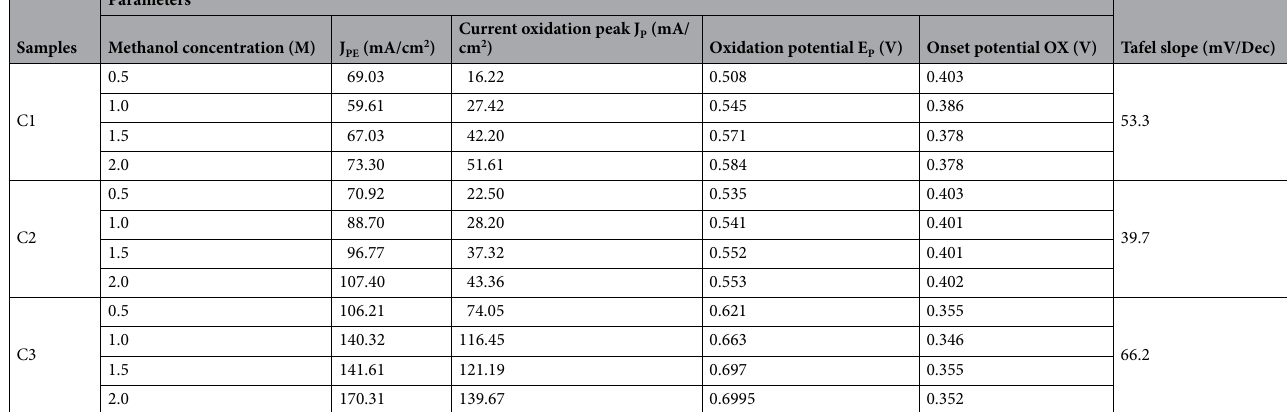
Onset potential. Onset potential is a meaningful metric used to assess EC activity. This represents the possibil- ity of the existence of reaction pathways in which all reaction steps have negative free energies. In other words, the electrode overpotential is indicated by the onset potential. In general, a more negative onset potential indi- cates higher activity and a lower overpotential, which then leads to an increase in over-cell potential 13–50 . Figure S3 shows the relationship between the methanol concentration and the onset potential for the prepared samples. From this figure, it is easy to observe that sample C3 has a small onset potential toward a negative position, which indicates that C3 shows high activity and less overpotential. The right electrocatalyst can lower the onset potential, making it easier for the reaction to occur. This is because electrocatalyst can facilitate the transfer of electrons between the reactants and electrode, reducing the energy required for the reaction to take place. This may be the case of Cr addition to Ni-Pt where Cr reduced the resistance as noticed from EIS measurements and reduced the onset potential. Also, it has been found that the onset potential decreases with decreasing lattice parameter for Bi and Pb series catalysts. The dependence of onset potential and lattice parameter showed a dif- ferent tendency for Ir and Rh series catalysts, that is, an initial increase and then a decrease. This dependence may be due to the different steric locations of the active center corresponding to the lattice parameters 51 . Influence of scan rate (SR). The experiment’s scan rate determines how quickly the applied voltage is scanned. Higher currents are seen as a result of faster SRs since they cause the diffusion layer’s size to shrink. The Ran- dles–Sevcik equation (Eq. 3) explains how the peak current i p increases linearly with the square root of the scan rate (V s -1 ) for electrochemically reversible electron transfer processes involving freely diffusing redox species.